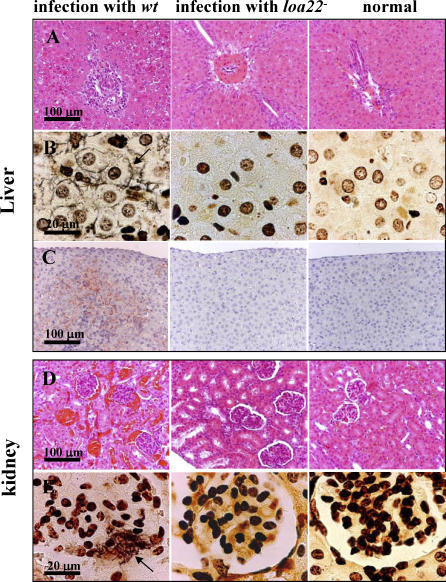
Livers and Kidneys from Guinea Pigs Infected with the Wild-Type Strain and Mutant loa22− StrainAll images are from guinea pigs 6 d post-inoculation. The right panels show normal livers (A–C) and kidneys (D and E). Tissues were stained by hematoxylin and eosin (×200, [A and D]), Warthin–Starry (×1000, [B and E]) and immunohistochemistry with antiserum specific to LipL32 (×200, [C]). Left panel, wild-type strain (wt); middle panel, mutant loa22− strain.(A–C) Livers of wt-infected animals exhibit important periportal lymphoplasmocitary inflammatory infiltration, loss of parenchymal architecture, and increase of biliary canalicules in comparison with a normal aspect of mutant loa22−. Distortion of liver cords is related to numerous leptospires along cell membranes of hepatocytes (arrow, [B]) in wt-infected animals.(D and E) Kidneys of wt-infected animals present hemorrhages in Bowman's spaces, lumen of renal tubules, and interstitium (D). A large number of leptospires is seen in Bowman's space (arrow), sometimes forming a cap (E). Histology of kidneys infected with mutant loa22− was considered as normal (D and E).